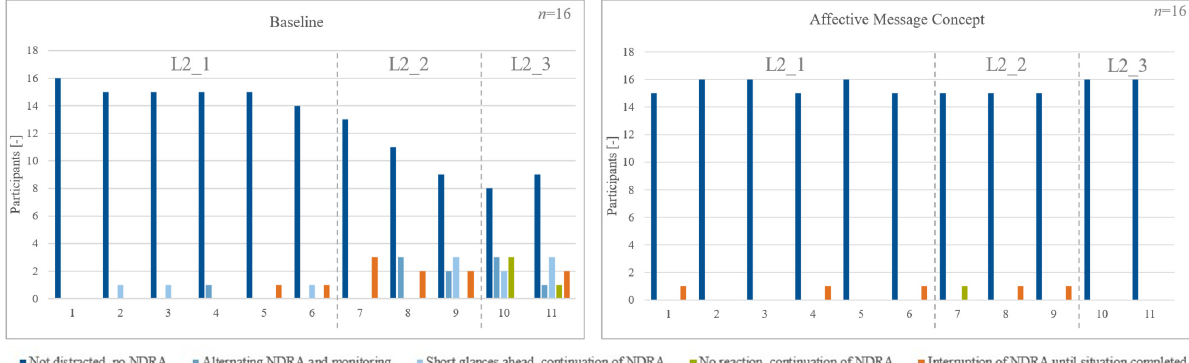
Figure 8. Coding of driver attentiveness during critical driving scenarios.